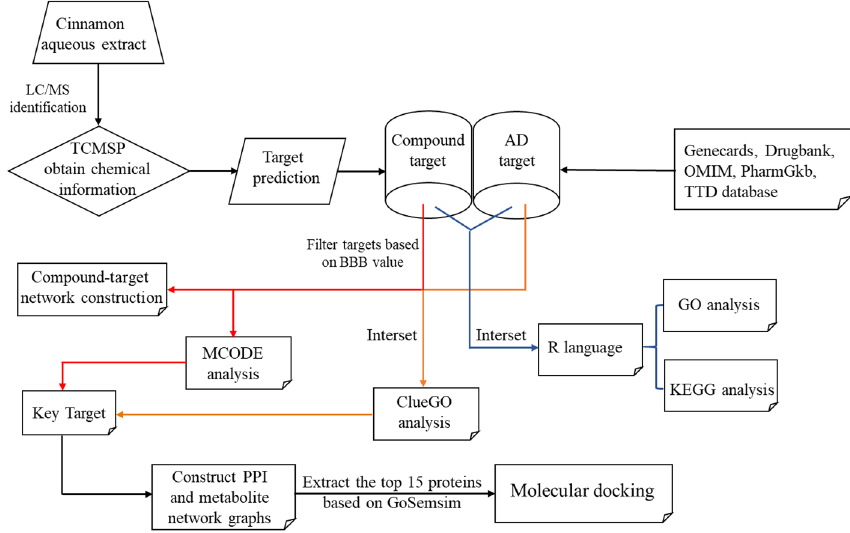
Figure 1. Research strategy to find AD-related GABAergic synapse dysfunction by identifying the active ingredients of cinnamon aqueous extracts.